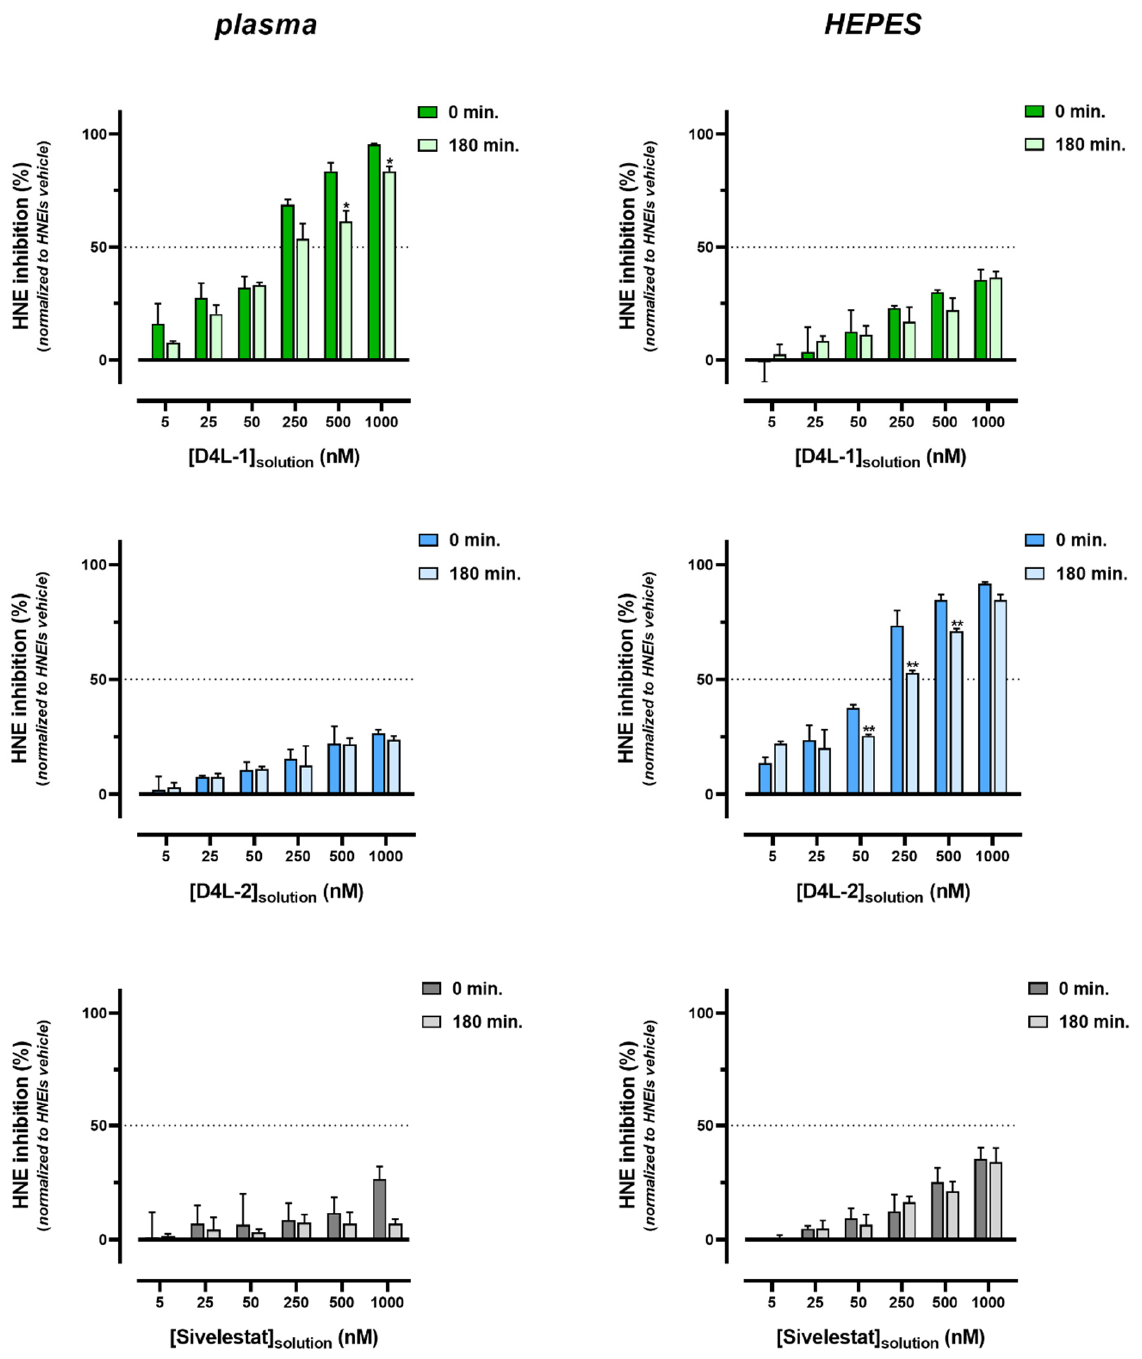
Figure 3. Human neutrophil elastase (HNE) inhibition of D4L-1-PSU, D4L-2-PSU, and Sivelestat-PSU membranes after incubations of 0 and 180 min with diluted plasma (left side) or HEPES buffer (right side) at 37 °C, assessed by the HNE activity assay. Data obtained from at least 3 independent experiments (performed in triplicate) are presented as mean ± SEM (standard error of the mean). Dotted line represents the IC50 value of the respective HNEI in HEPES 0.1M, pH 7.4 buffer. * p < 0.05, ** p < 0.01 statistical analysis results of time of incubation comparison for the respective initial solution concentration of each HNEI-PSU doped membrane (Student’s t test); p < 0.05 was considered statistically significant. For each assay, HNE inhibition was standardized establishing that PSU membranes incubated with HNEIs’ vehicle (2.5% DMSO) samples corresponded to zero (minimum).